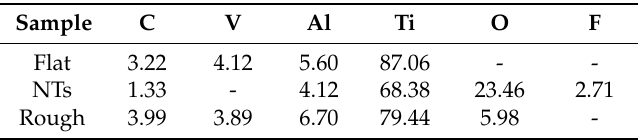
Table 1. Chemical composition of the materials surfaces by energy dispersive X-ray spectroscopy (EDX). Sample C